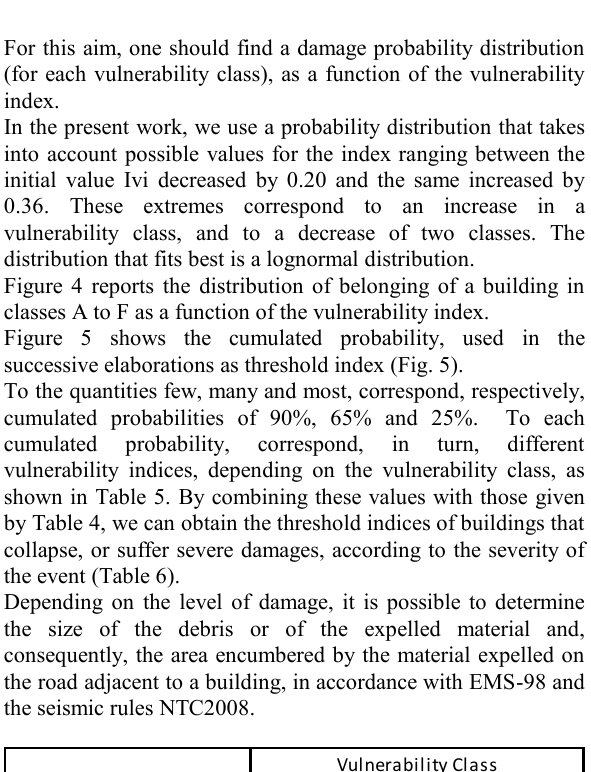
Figure 5. Cumulated probability of belonging of a building in classes A to F as a function of the vulnerability index.